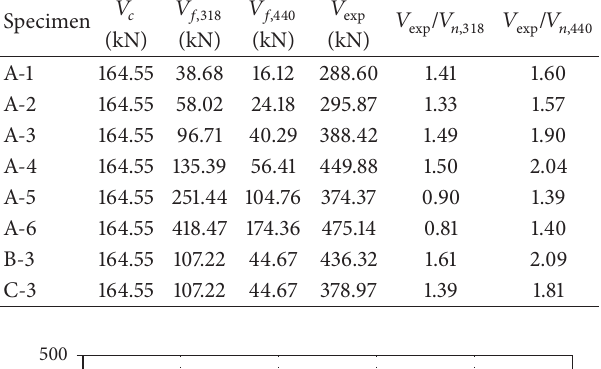
Table 4: Experimental results and ratio of shear strength. Specimen